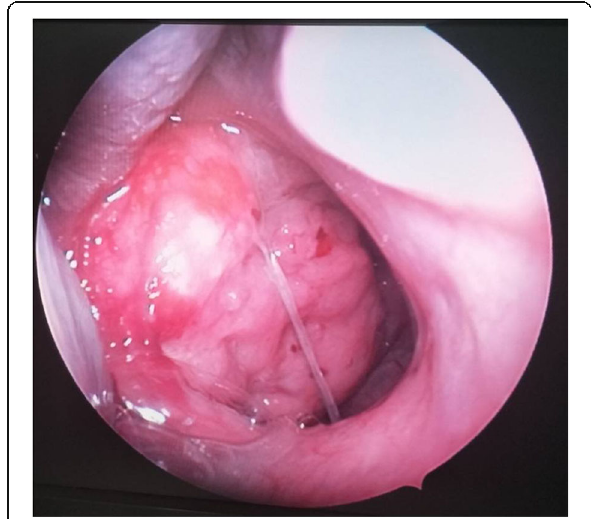
Fig. 3 Endoscopic picture showing an irregular mass at the right posterosuperior part of the nasopharynx